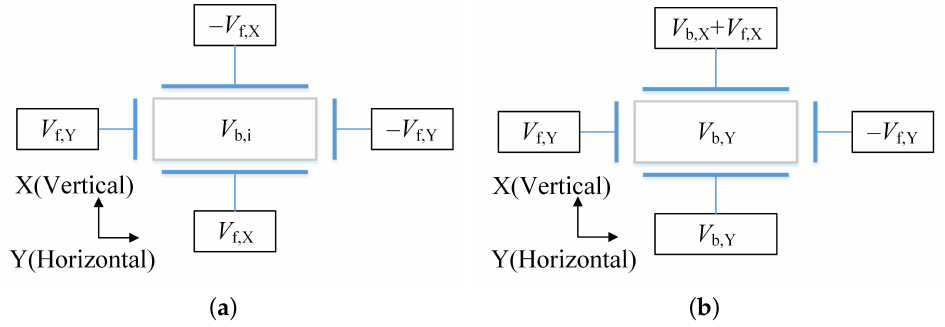
Figure 2. The electrostatic force scheme ( a ) on-orbit satisfies the relationship in (1), and the terrestrial scheme ( b ) to obtain optimal characteristics with 1-g input along the vertical